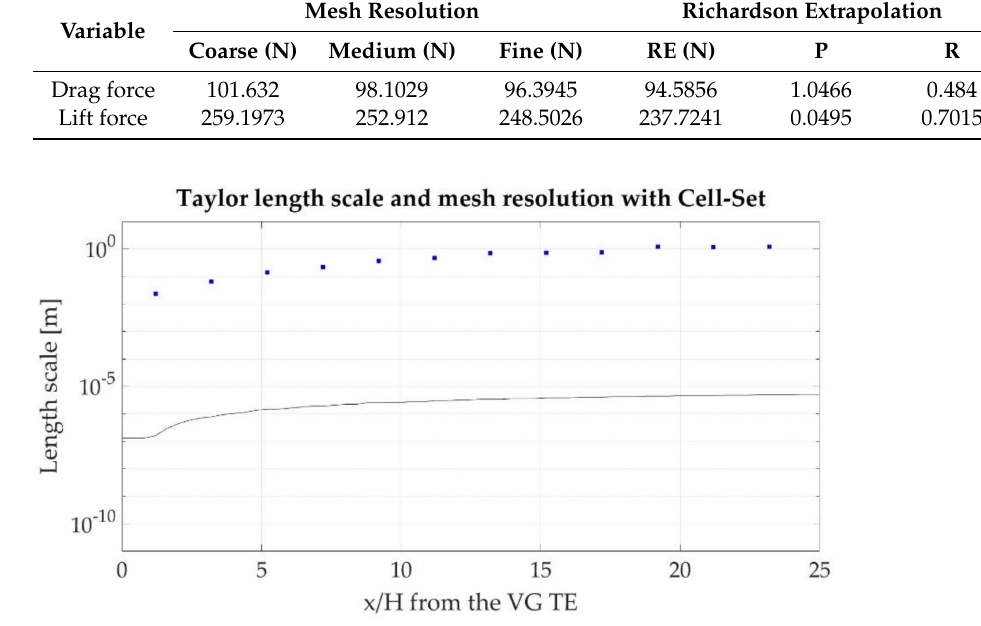
Figure 6. Mesh resolution and Taylor length scale on the wake behind the VG at y/ δ = 1 for the case H = 1 δ with the cell-set